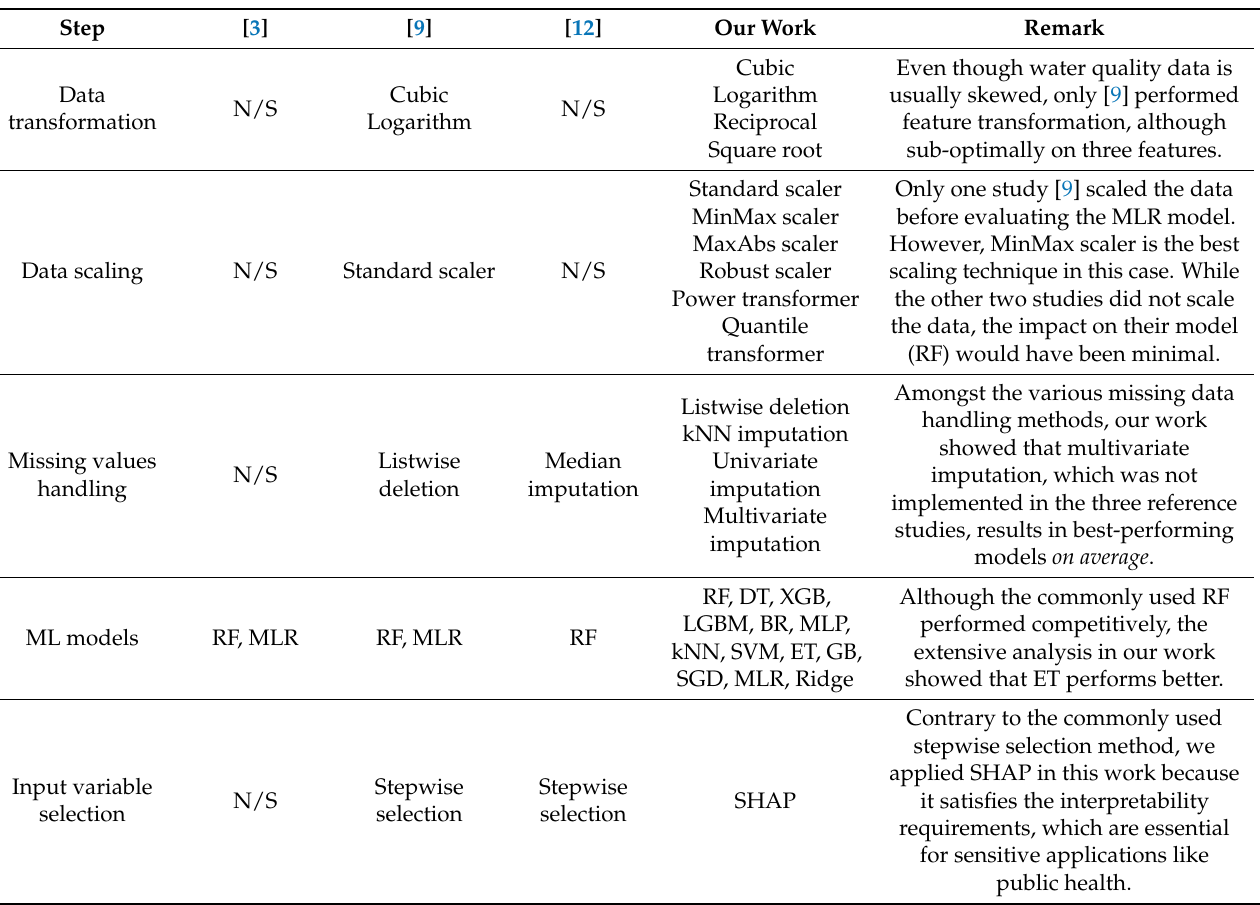
Table 11. A methodological comparison of our work with the three most related studies, where N/S = not specified, ML = machine learning, kNN = k-nearest neighbor, RF = random forest, MLR = multiple linear regression, DT = decision tree, XGB = extreme gradient boosting, LGBM = light gradient boosting machine, BR = bagging regressor, MLP = multi-layer